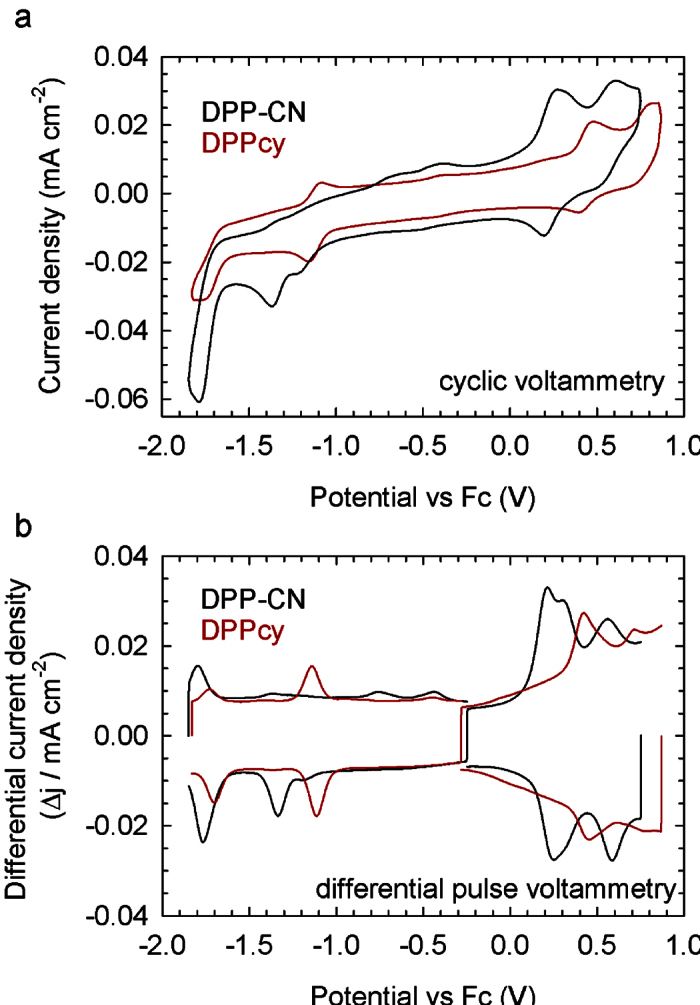
(a) Cyclic voltammetry and (b) differential pulse voltammetry traces of DPP-CN (black lines) and DPPcy (red lines) in a 2:1 CH3CN:CH2Cl2 solution with tetrabutylammoniumtetrafluoroborate 0.1 M as the supporting electrolyte.